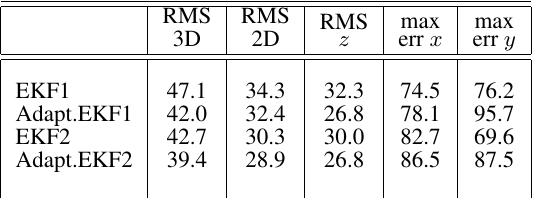
Table 1. UWB positioning errors